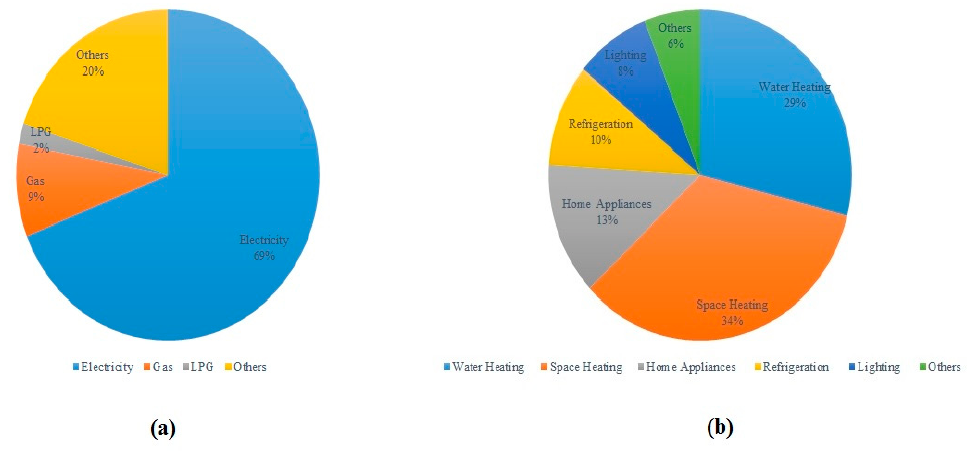
Figure 1. ( a ) Total energy consumption by energy type; ( b ) total energy consumption by end-use.